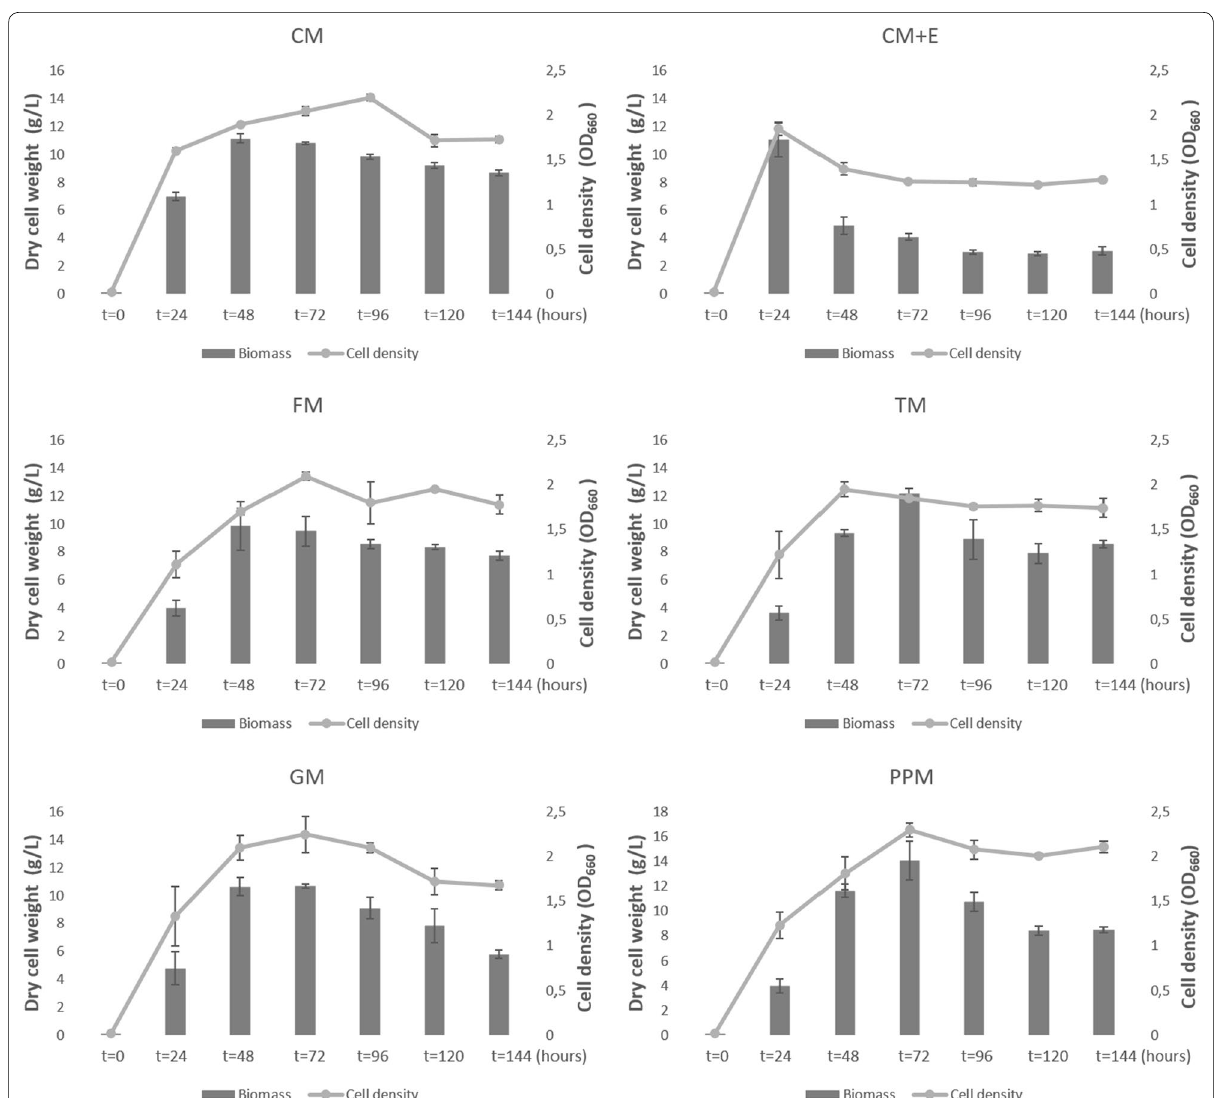
Fig. 1 Growth curve of Schizochytrium sp. in different mediums: Schizochytrium sp. were grown in CM, CM E, FM, TM, GM, PPM mediums with + total 144 h incubation. The highest cell biomass during incubation was achieved at 72th hours in TM, GM, PPM while in CM and FM it was achieved at 48th hours. CM E has shown lower biomass accumulation pattern in comparison with other mediums. The cell density pattern in FM, GM and + PPM has shown highest value at 72th hours and TM has shown the very near results at 48 and 72th hours for the highest cell density. In CM, highest cell density was achieved at 96th hours. In CM E cell density has not changed significantly after introduction of ethanol at 24th hours and it was + rather lower than other